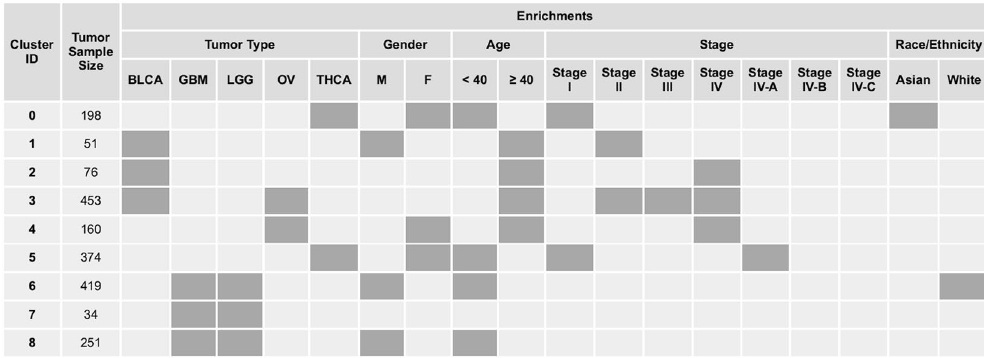
Figure 4. t-SNE Embedding-derived Patient Attribute Enrichment. Consensus cluster identification and attribute enrichment results from 1000 t-SNE embeddings of the 48 transcripts. Gray boxes indicate significant enrichment (p <